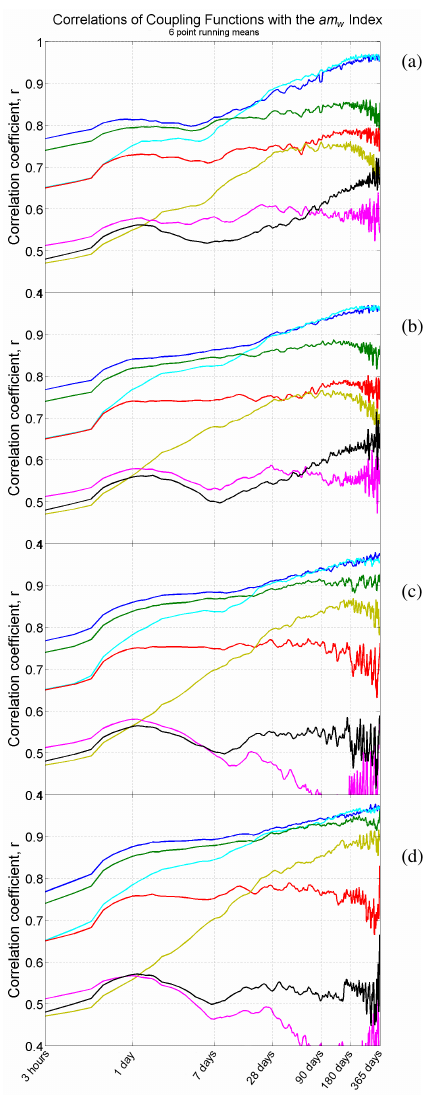
Fig. 10. Correlations between the am w index and a number of coupling functions, illustrating the importance of considering how much data contributes to each data point in the correlation. The corresponding significance levels are shown in Fig.